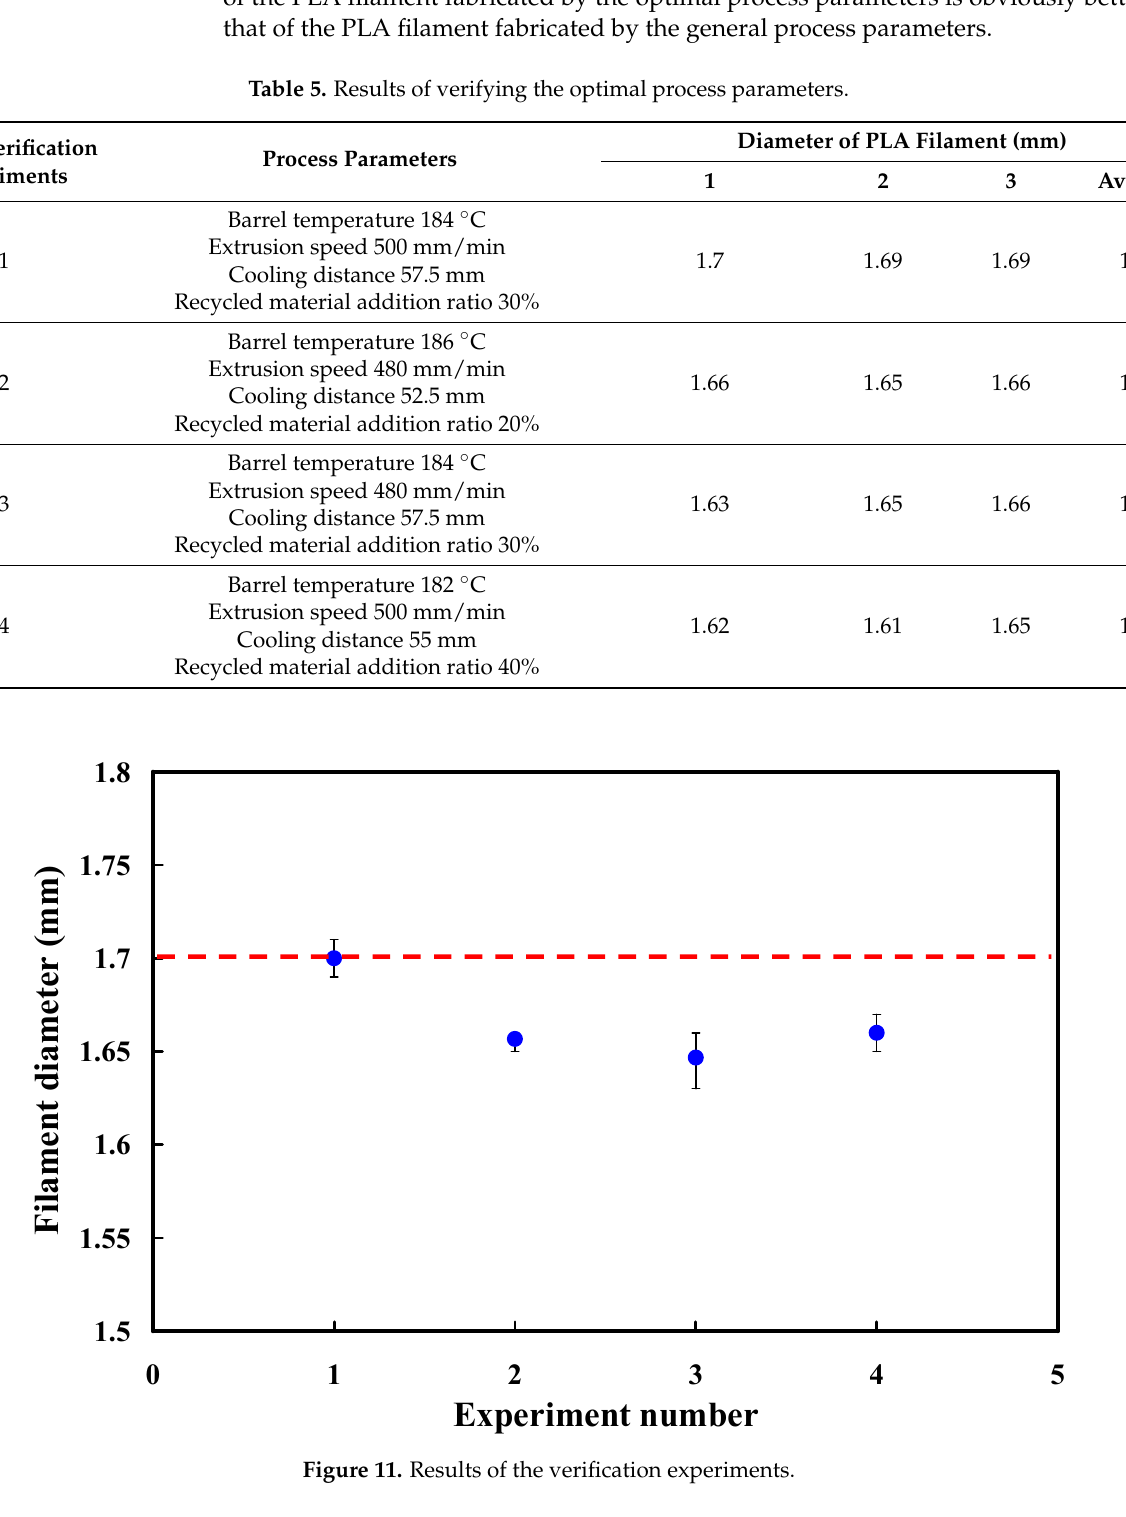
Table 5. Results of verifying the optimal process parameters.